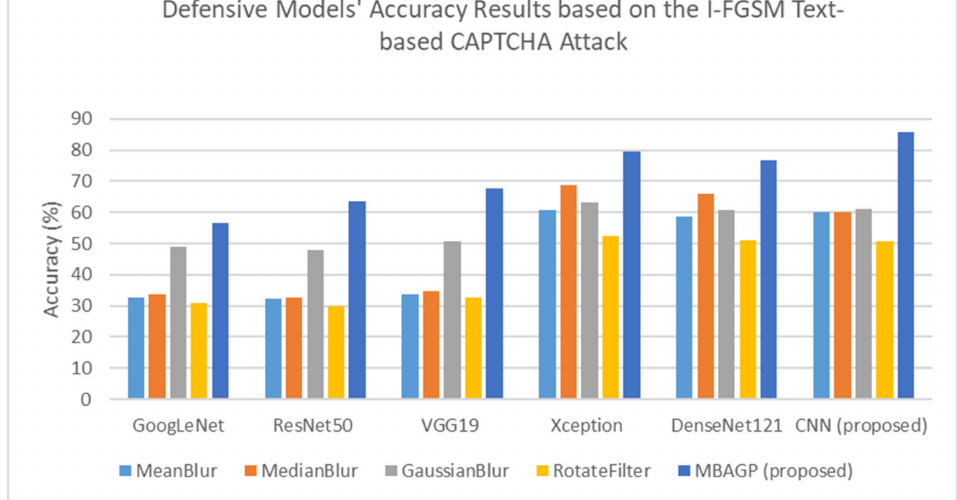
Figure 20. Comparison results of the testing accuracies obtained by the defense models based on the I-FGSM text-based CAPTCHA attack, in terms of the proposed MBAGP-CNN